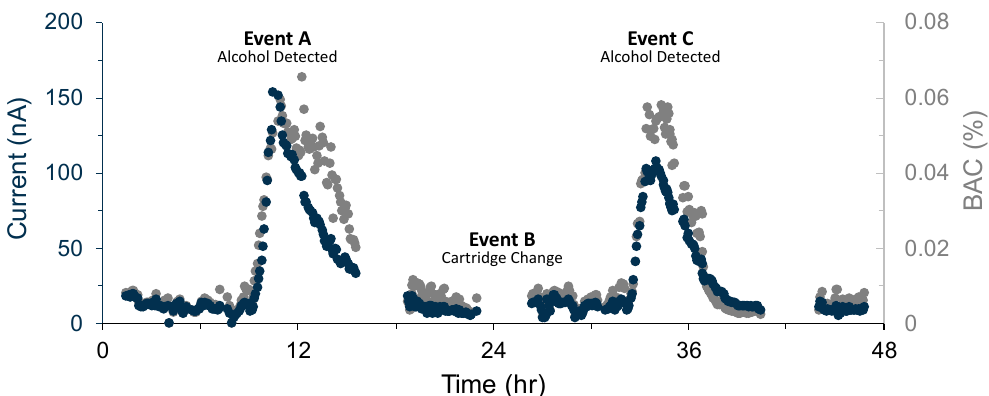
Figure 4. Electrical current measurements (blue) and Blood Alcohol Concentration (BAC) calculated using Equation (7) (gray) versus